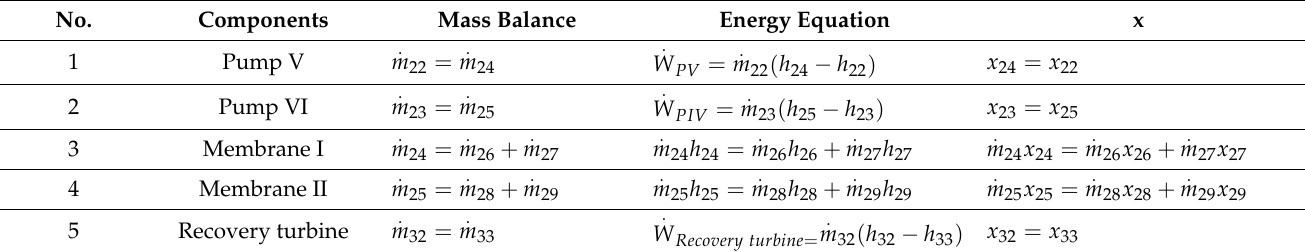
Table 3. Mass, energy, and concentration balance relationships for the RO